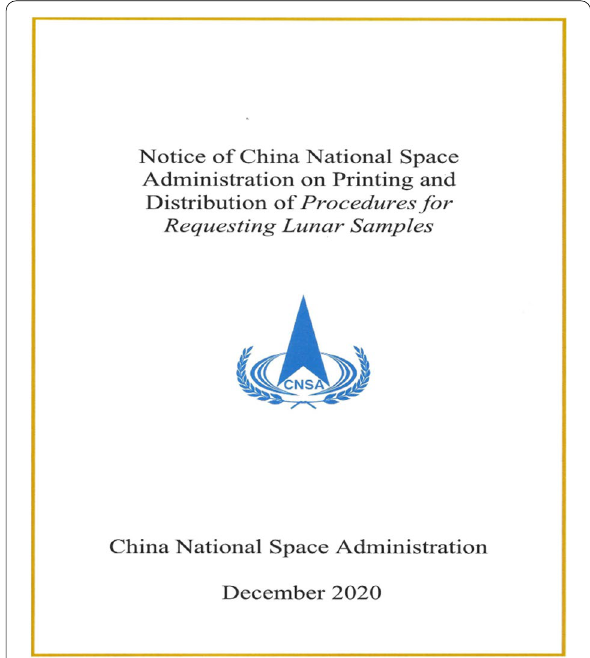
Fig. 5 Official Document: “Procedures for Requesting Lunar Samples” (Online: http:// www. gov. cn/ zheng ce/ zheng ceku/ 2021- 01/ 18/ conte nt_ 55807 72.